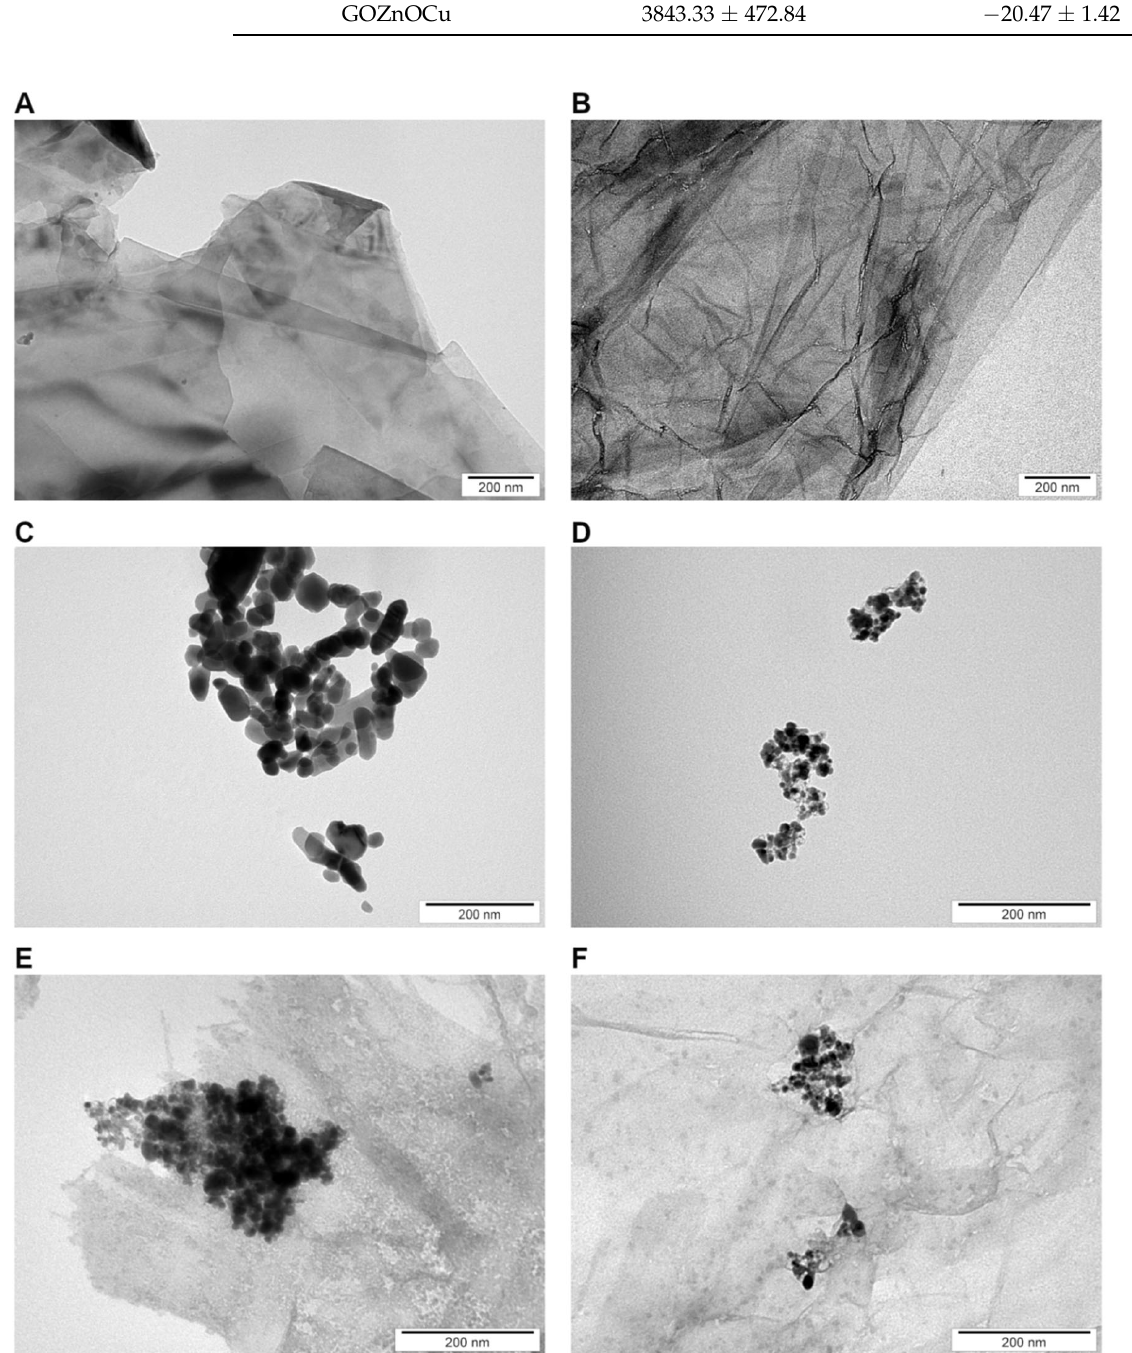
Figure 2. Visualization of nanomaterials by TEM: ( A ) GN; ( B ) GO; ( C ) ZnO; ( D ) Cu; ( E ) GNZnOCu; ( F ) GOZnOCu. The FT ‐ IR spectra of GN, GO, and ZnO as well as their composites are shown in Figure 3. The broad peak observed between 3000 and 3650 cm − 1 is assigned mainly to the water and hydroxyl groups (O ‐ H). The smaller features from 2850 to about 3000 cm − 1 can be attributed to the C–H stretch and C–H bending around 1310 cm − 1 . The peak around 1615 cm − 1 can be assigned to aromatic (sp 2 vibrational) C=C bonds that are present in graphitic carbon. Another peak was observed around 1500 cm − 1 on the FT ‐ IR spectrum revealed C=O bonds. An absorption band at 1385 cm –1 was present because of aliphatic C–C bonds (sp 3 C–H bend). The overlapping peaks, which form an absorption band in the 1300–950 cm − 1 region, can be attributed to C–O moieties existing in a different struc ‐ tural environment [27,28].